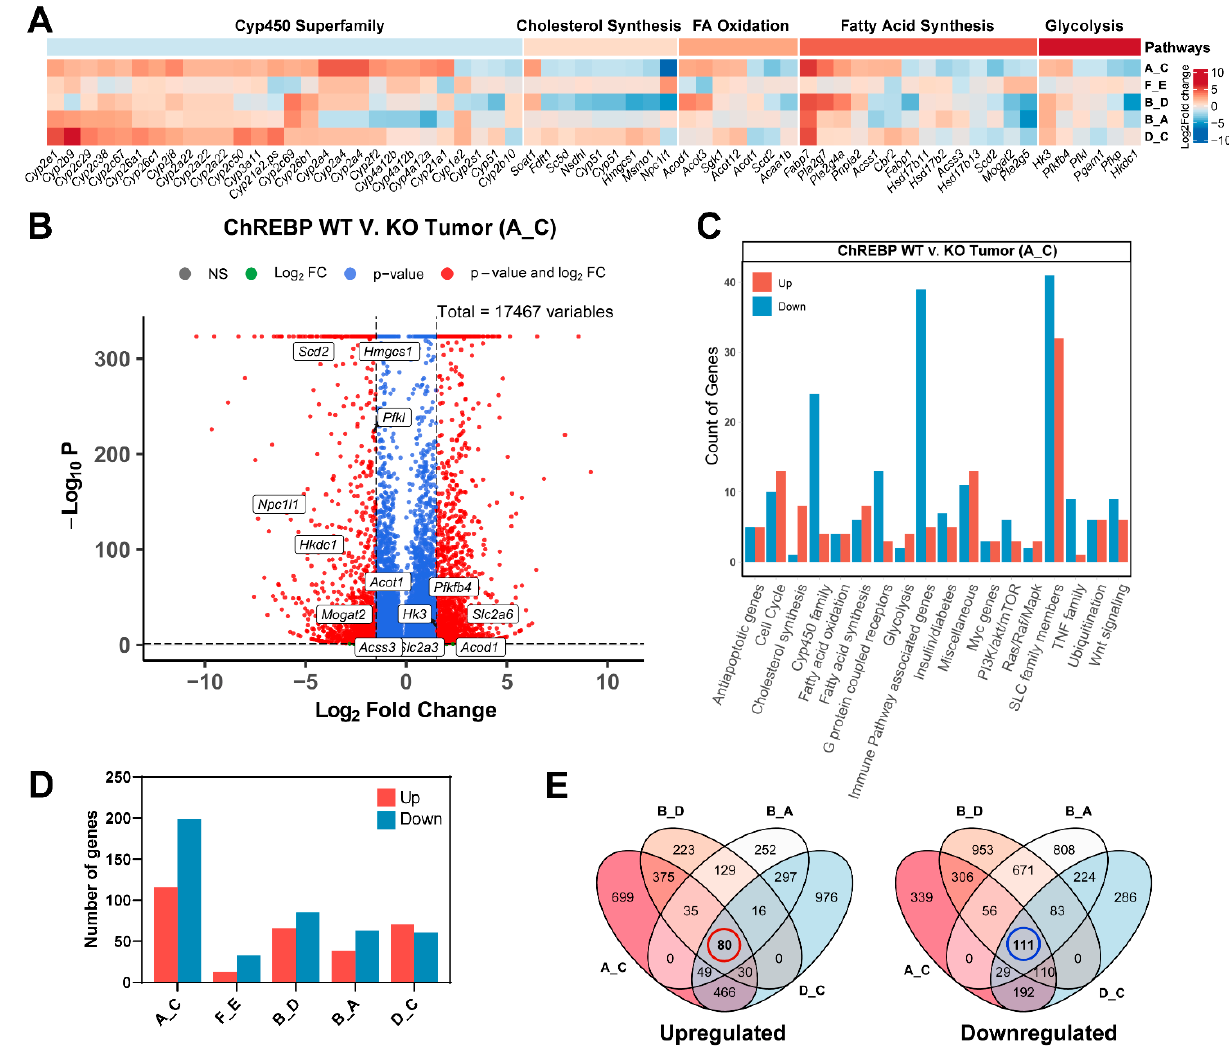
Figure 6. Systemic loss of ChREBP downregulates the expression of transcripts that encode enzymes involved in metabolic processes and vice versa. ( A ) A heat map representing altered significant metabolic genes involved in critical pathways of ChREBP +/+ WT and ChREBP − / − tumors. Significance in up- and downregulation was calculated using log2 fold change >0.6 and p -value <0.05. ( B ) An enhanced volcano plot comparing the differentially expressed genes and highlighted some dysregulated genes in total 17,467 variables between ChREBP WT and KO tumor. The plot represents the negative log10 of the p -value (Y-axis) and log2 of the fold change of gene expression (X-axis) for individual transcript of WT vs. KO tumor. The broken vertical lines represent fold change values of ± 1.5. FC, fold change. ( C ) Bar plot showing dysregulated (up/down) genes of certain families (as in B) that function through mentioned processes. ( D ) Bar plot indicating the overall identified genes that are consistently dysregulated between groups. ( E ) Venn diagram demonstrating combined up- and downregulated genes when the comparison between A_C, B_D, B_A and D_C according to supplementary Figure S10 was performed. Shown in the red circle is the number of upregulated genes (80) and the number (111) in the blue circle represents downregulated gene